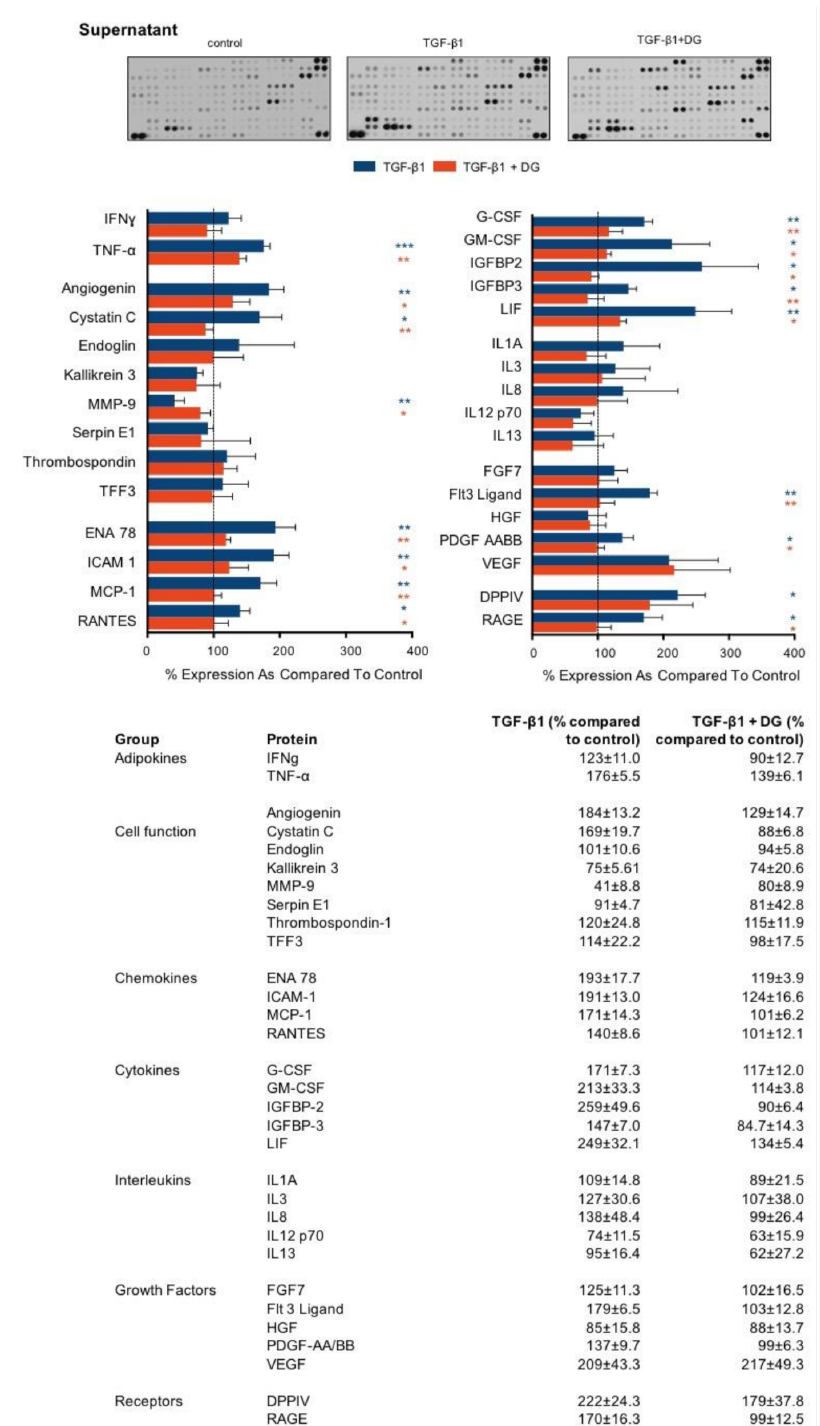
Figure 7. Danegaptide prevents TGF β 1-evoked changes in the secretion of adipokines, chemokines, growth factors and interleukins. Primary hPTECs were cultured in low glucose (5 mM) ± TGF β 1 (10 ng/mL) ± danegaptide (100 nM) for 48 h. An inflammation antibody array was used to assess the secretion of 31 candidate inflammatory proteins in the supernatant from treated hPTECs. Results are representative of 3 separate experiments and presented as the mean ± SEM ( n = 3), with key significances indicated (* p < 0.05, ** p < 0.01, *** p < 0.001; one-way ANOVA and Tukey’s